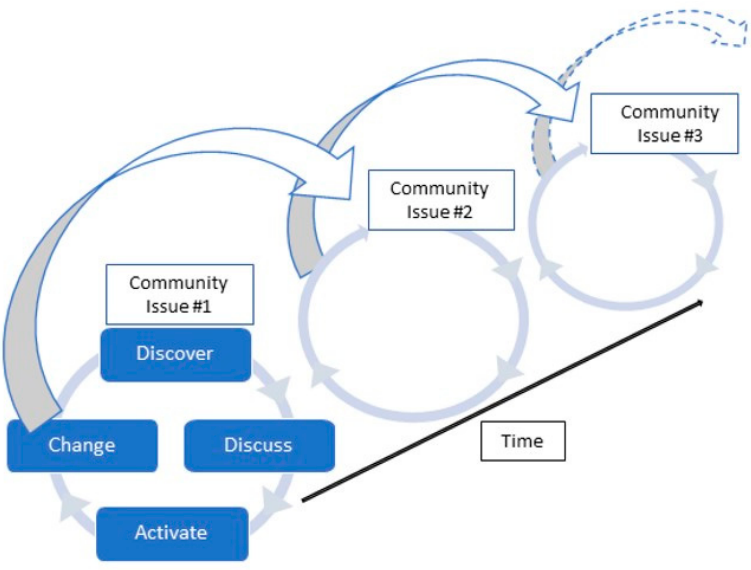
Figure 2. The OV method strategy for cumulative, cyclical community impact over time.